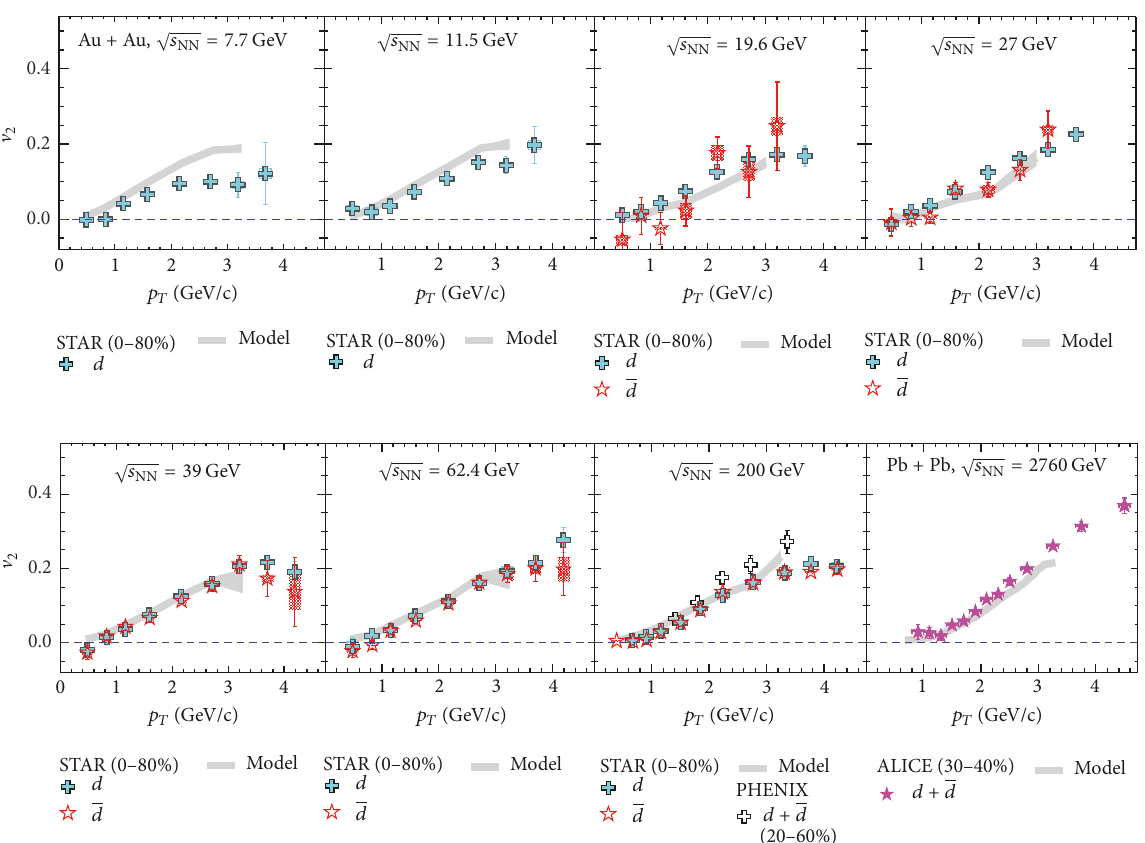
Figure 8: Light nuclei V 2 as a function of 𝑝 𝑇 from AMPT + coalescence model (solid lines). Marker for STAR experiment corresponds to 0–80%, PHENIX corresponds to 20–60%, and ALICE corresponds to 30–40% central